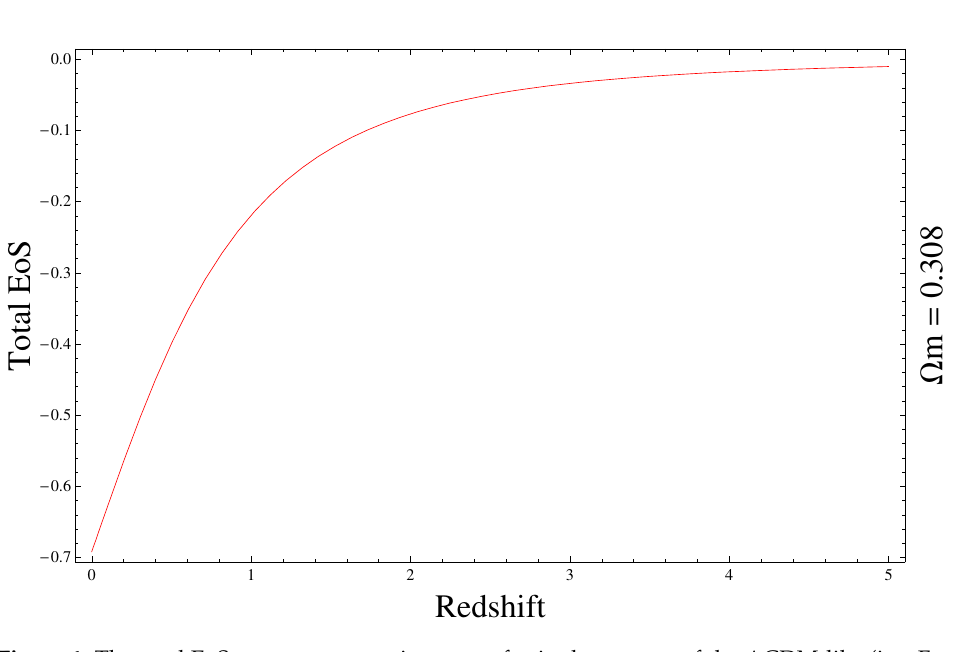
Figure 4. The total EoS parameter, w tot , in terms of z , in the context of the Λ CDM-like (i.e., Γ = 0) limit of the polytropic DM model. Notice that, today (i.e., at z = 0 ) , w tot ≈ − 0.7, while, for larger values of z , it approaches zero, in absolute agreement with Λ CDM cosmology